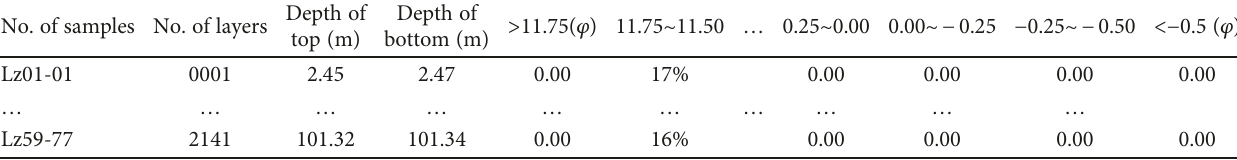
No. of samples No. of layers